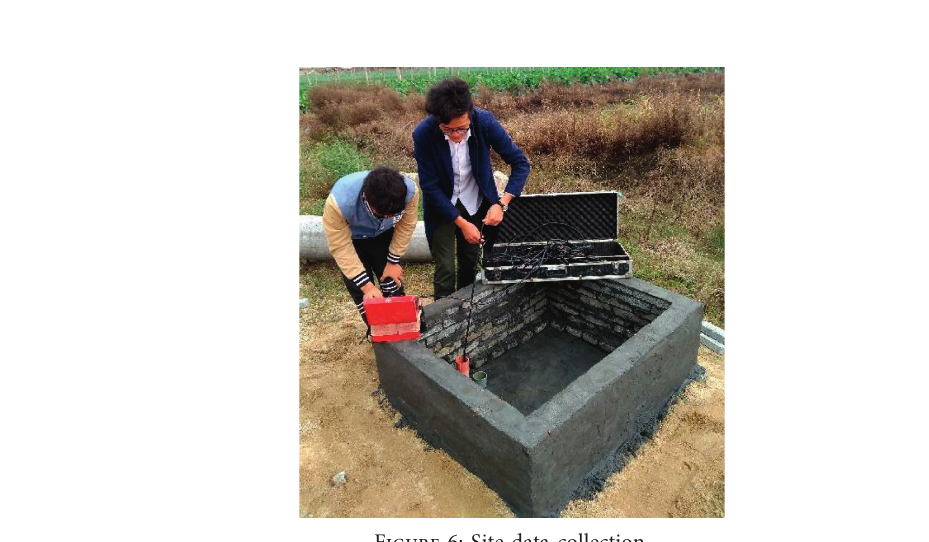
Figure 5: Cross-sectional view of the embankment.